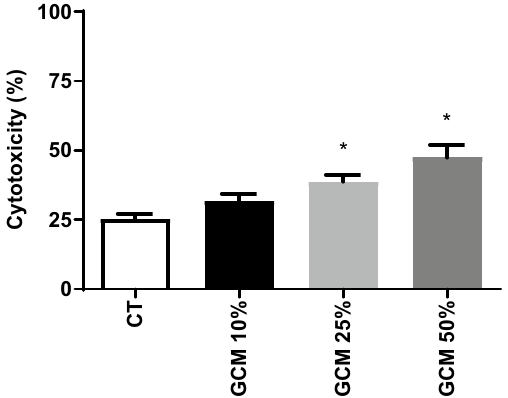
Figure 5. Effects of GCM -induced cytotoxicity of mouse neurons. The primary embryonic culture of neurons was subjected to 24-h treatment with GCM in different concentrations (25% and 50%). Cytotoxicity was assessed by the LDH assay. One-way ANOVA analysis, followed by Tukey’s post-test, *p < 0.05. Results are presented as mean ± SEM of 5 independent experiments.